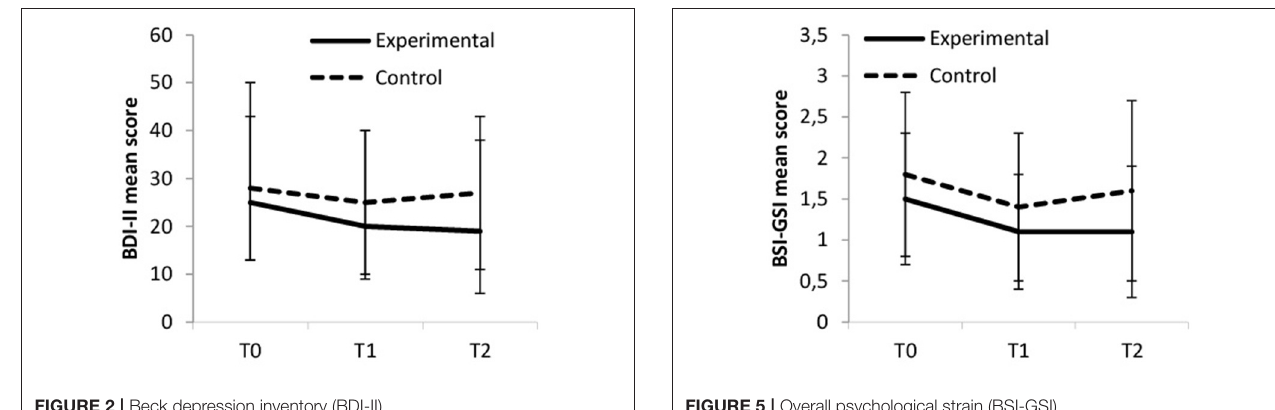
FIGURE 2 | Beck depression inventory (BDI-II).